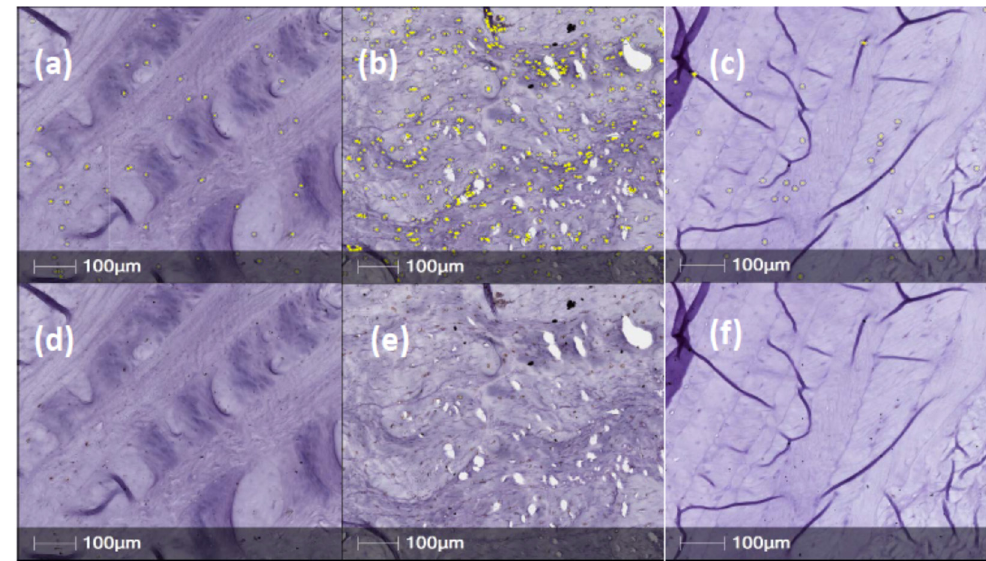
Figure 2. Representative sample of nerve growth factor receptor (NGFr/TrkA) expression in normal, PBS (n = 11) and NTG-101 (n = 16) injected IVDs. ( a – c ) Top panels show immunopositively stained cells overlaid in yellow by HALO automated cell counting software. ( d – f ) Identical sections without yellow overlay immunostained for TrkA with the DAB chromogen are shown in the bottom panels.